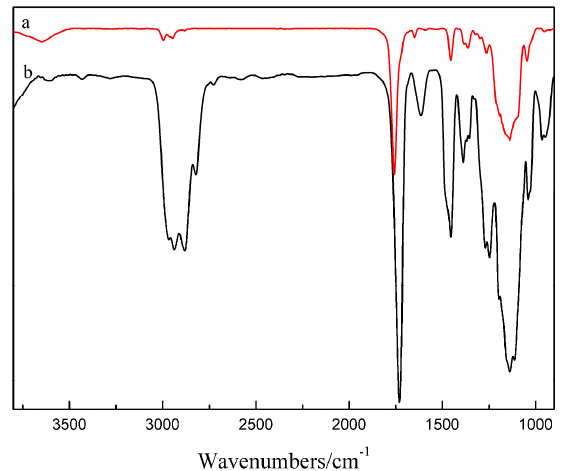
Figure 1. Fourier-transform infrared spectroscopy (FTIR) spectra of ( a ) chemical cross-linked gel5, ( b ) the double-crosslinked gel.